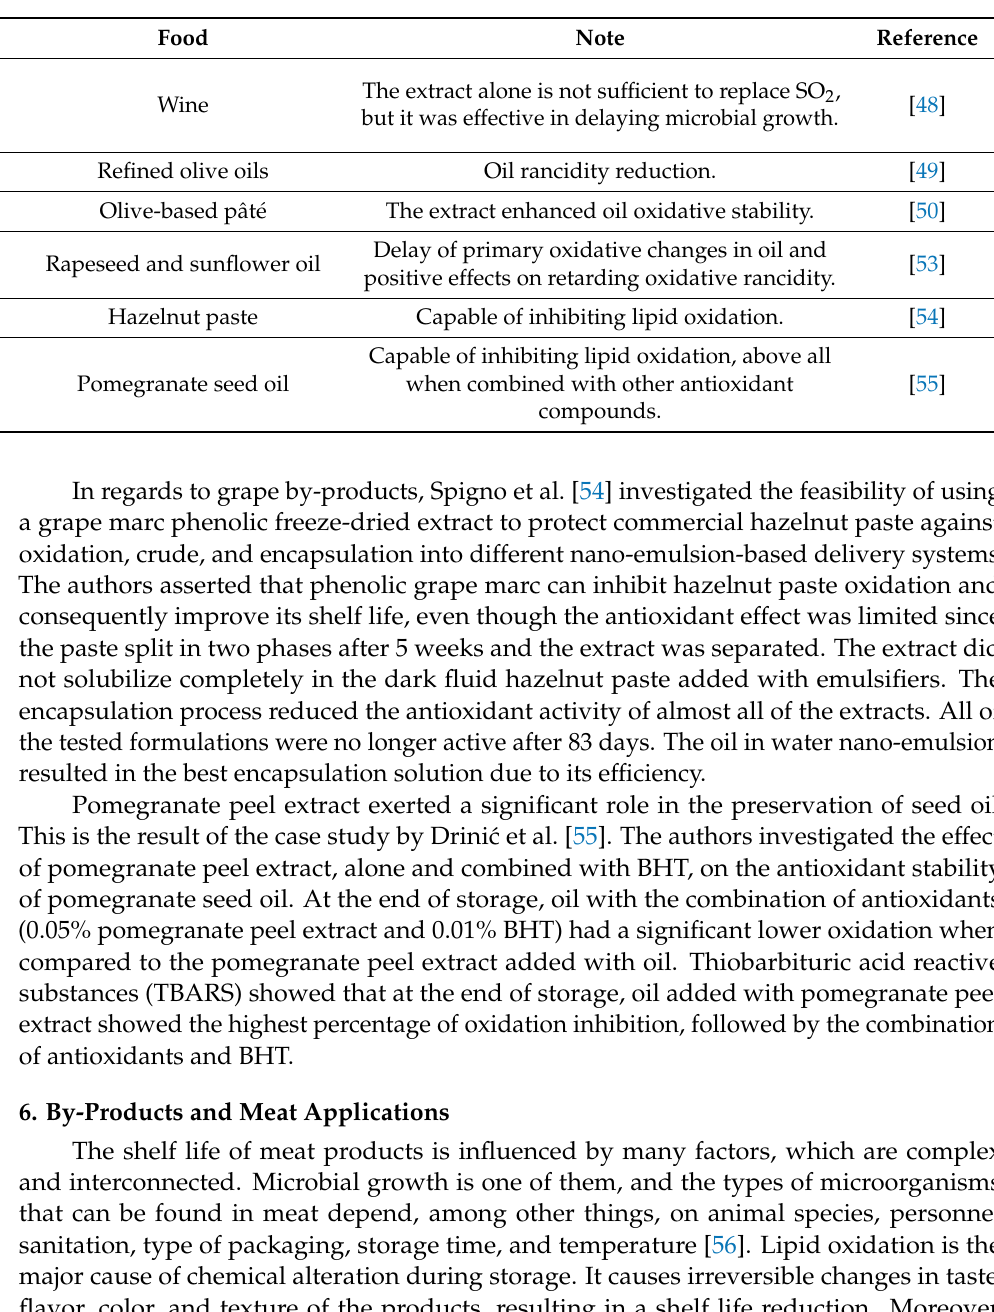
Table 3. Applications of by-products to vegetable-based processed